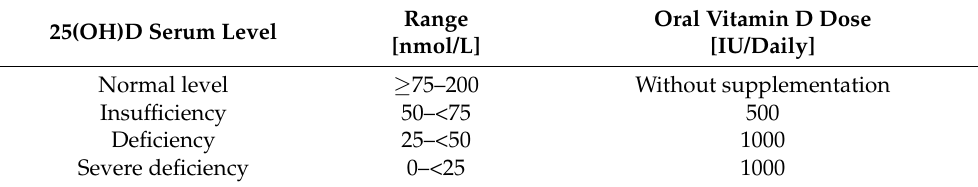
Table 1. Vitamin D supplementation algorithm